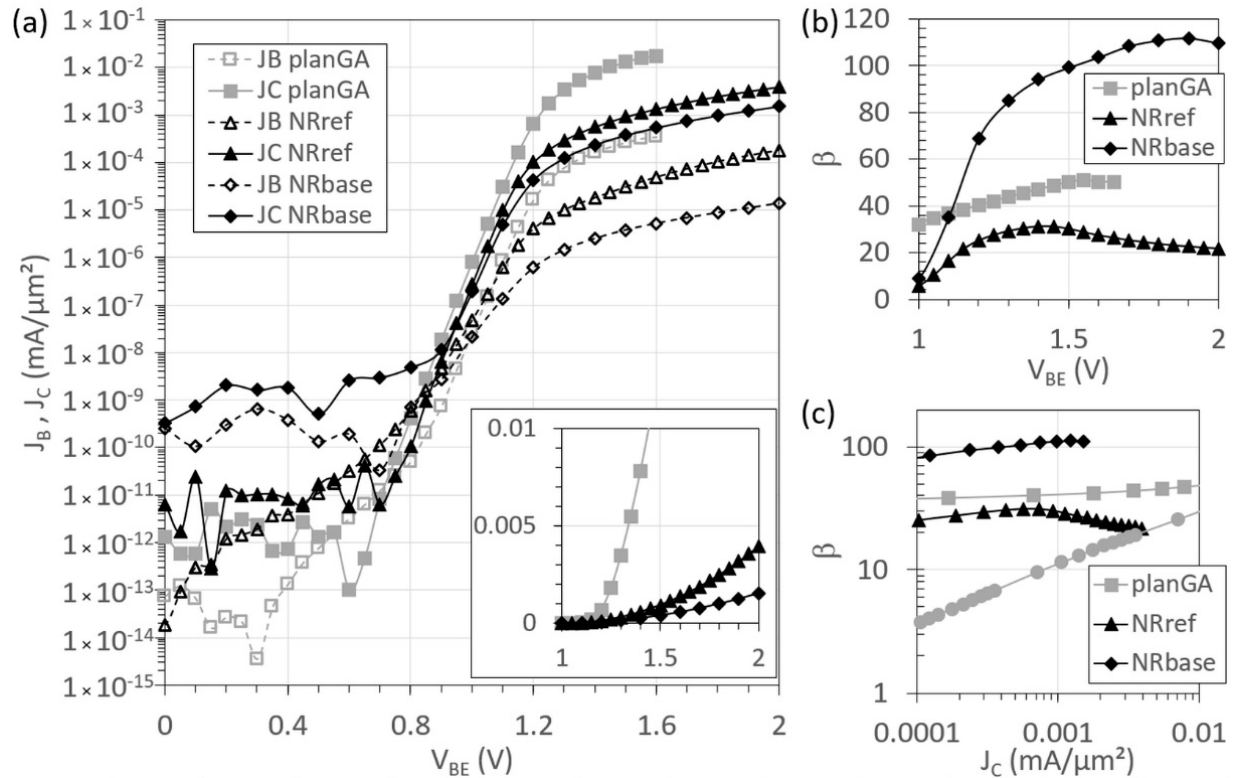
Figure 10. DC electrical characterization of our planar HBT on GaAs (planGA), the reference NR HBT on Si (NRref) and the NR HBT with lower p -doped base on Si (NRbase). ( a ) J B , J C (inset: J C on linear scale) and ( b ) current gain β as function of V BE , measured at V CB = 0. ( c ) Benchmarking DC current gain with respect to collector current density to literature data of an InGaP/GaAs HBT on Ge-on-Si (lit-Ge/Si) [29].